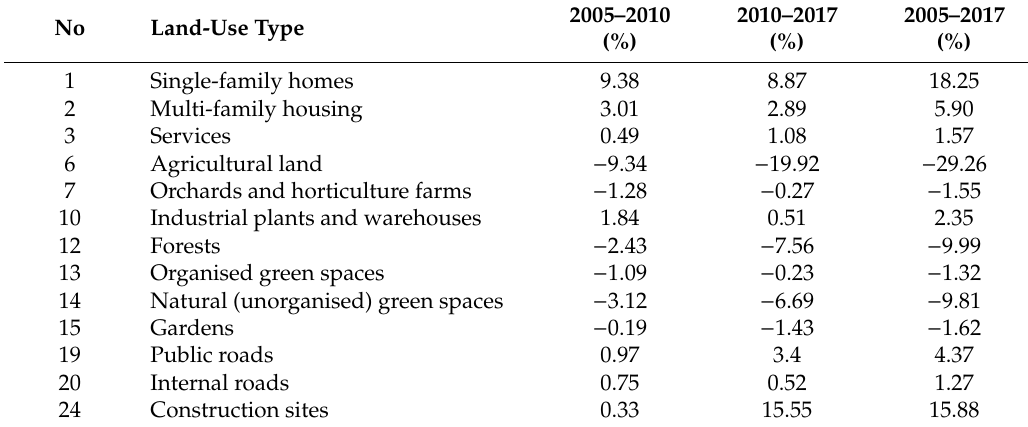
Table 3. Changes in land-use types in the studied area in